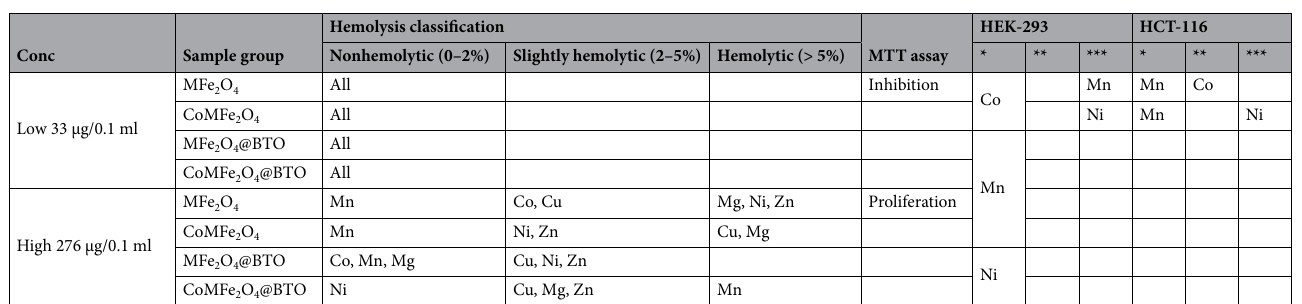
Table 3. Summary of hemolysis and cytotoxicity effects of MNPs and MENCs on RBCs, human embryonic kidney HEK-293 and human colorectal cancer HCT-116 cell